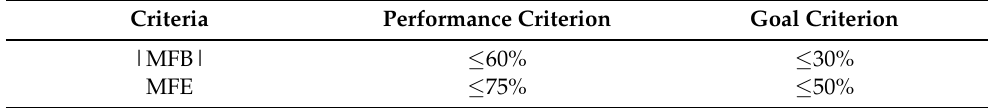
Table 2. Boylan and Russel